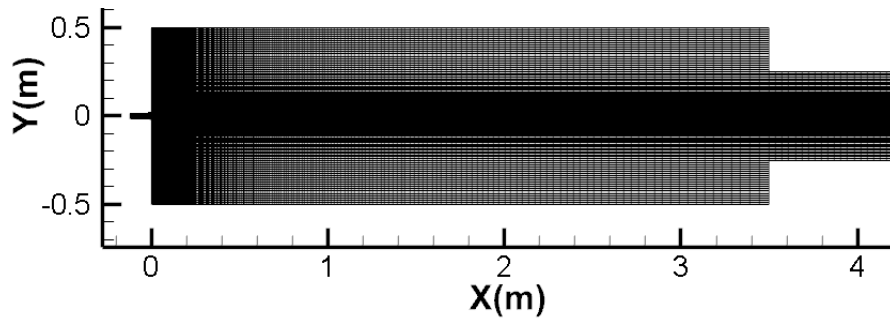
Figure 1. Diagram profile of simplified model of casing swirl burner.